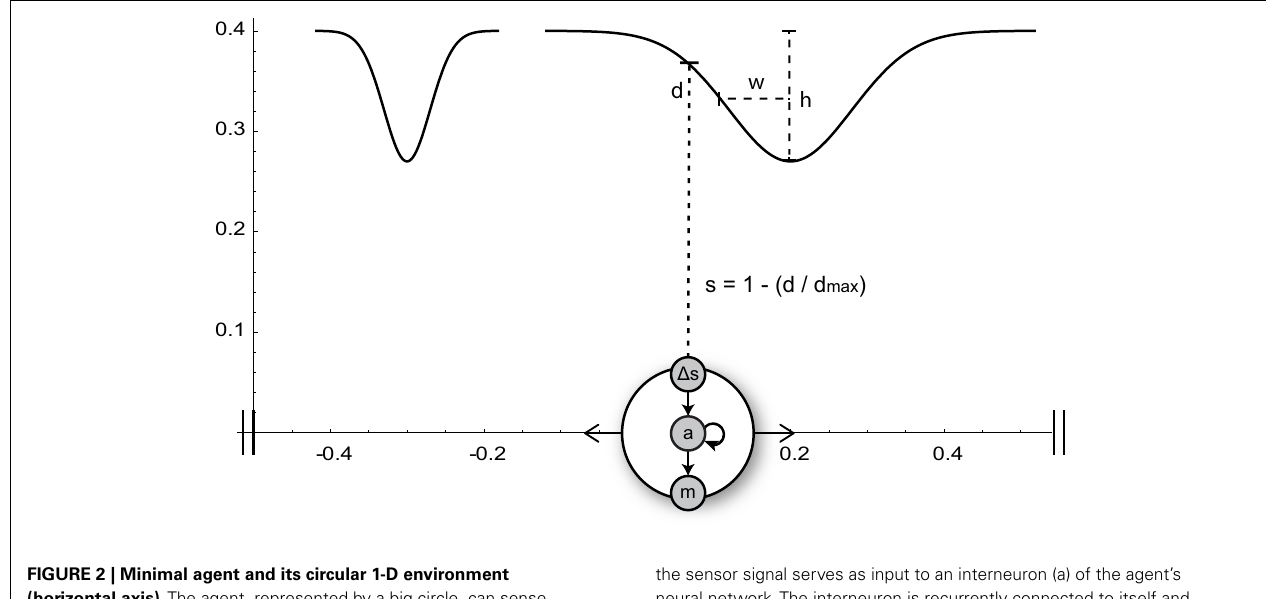
FIGURE 2 | Minimal agent and its circular 1-D environment (horizontal axis) .The agent, represented by a big circle, can sense the normalized proximity s to objects in front of it (narrow or wide Gaussian shapes of height h and width w).The time-derivative ( ∆ s) of